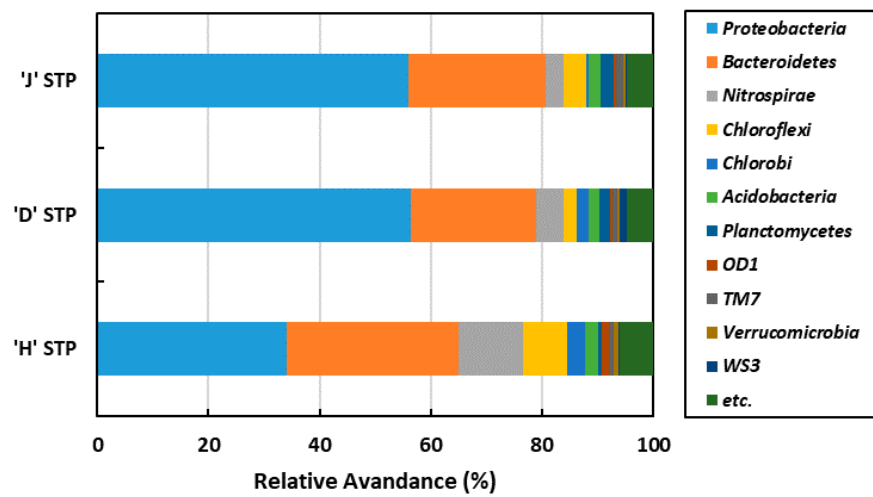
Figure 5. Comparison of the microbial community structures of WAS in each STP.